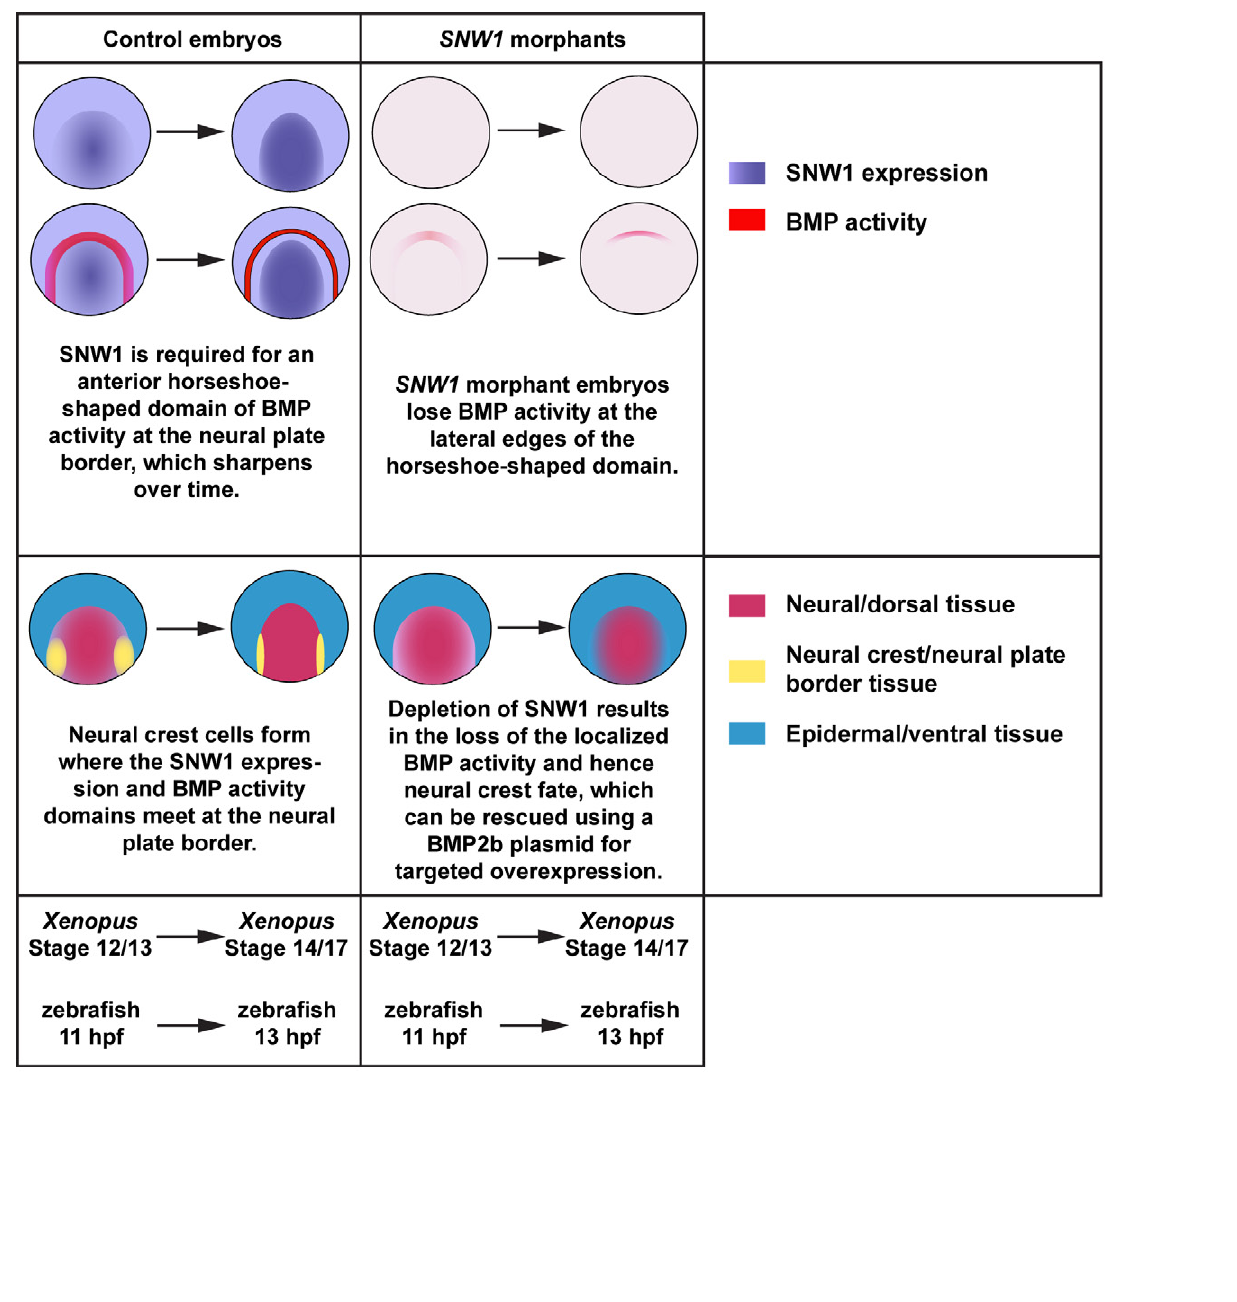
Figure 9. A model of SNW1 function. A schematic diagram summarizing our findings in both Xenopus and zebrafish embryos. A dorsal-anterior view of a schematized embryo is